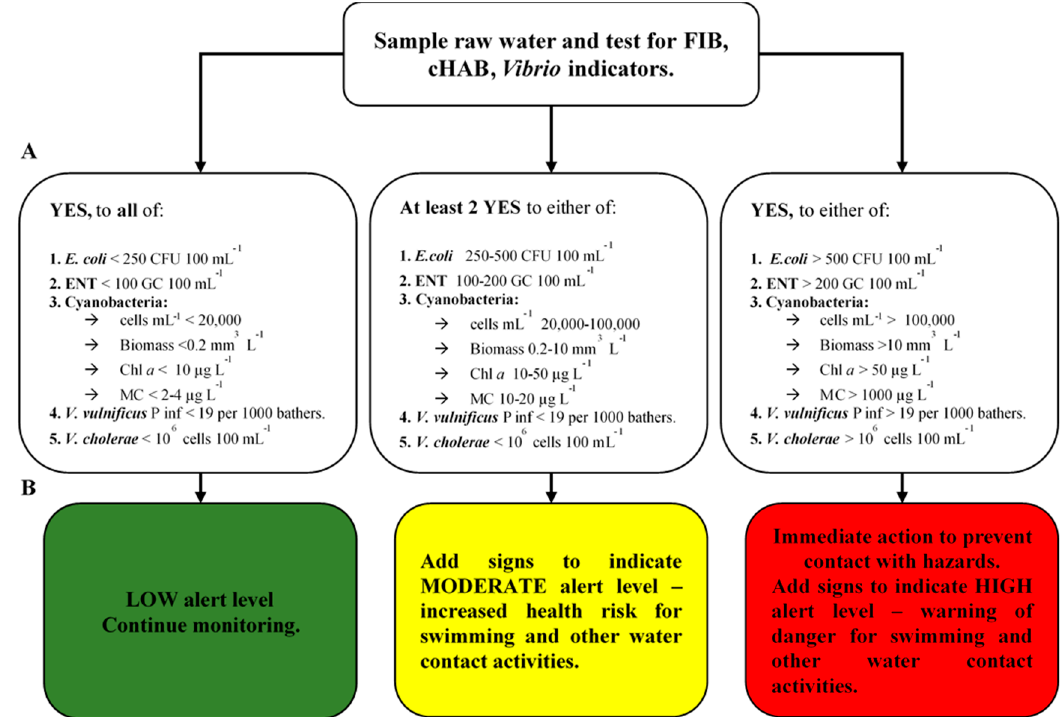
Figure 6. Decision tree for interpretation of integrated microbial risk assessment in recreational waters: ( A ) microbial indicators of water quality and their thresholds (from Table 2); and ( B ) decision-making and recommendations for authorities.